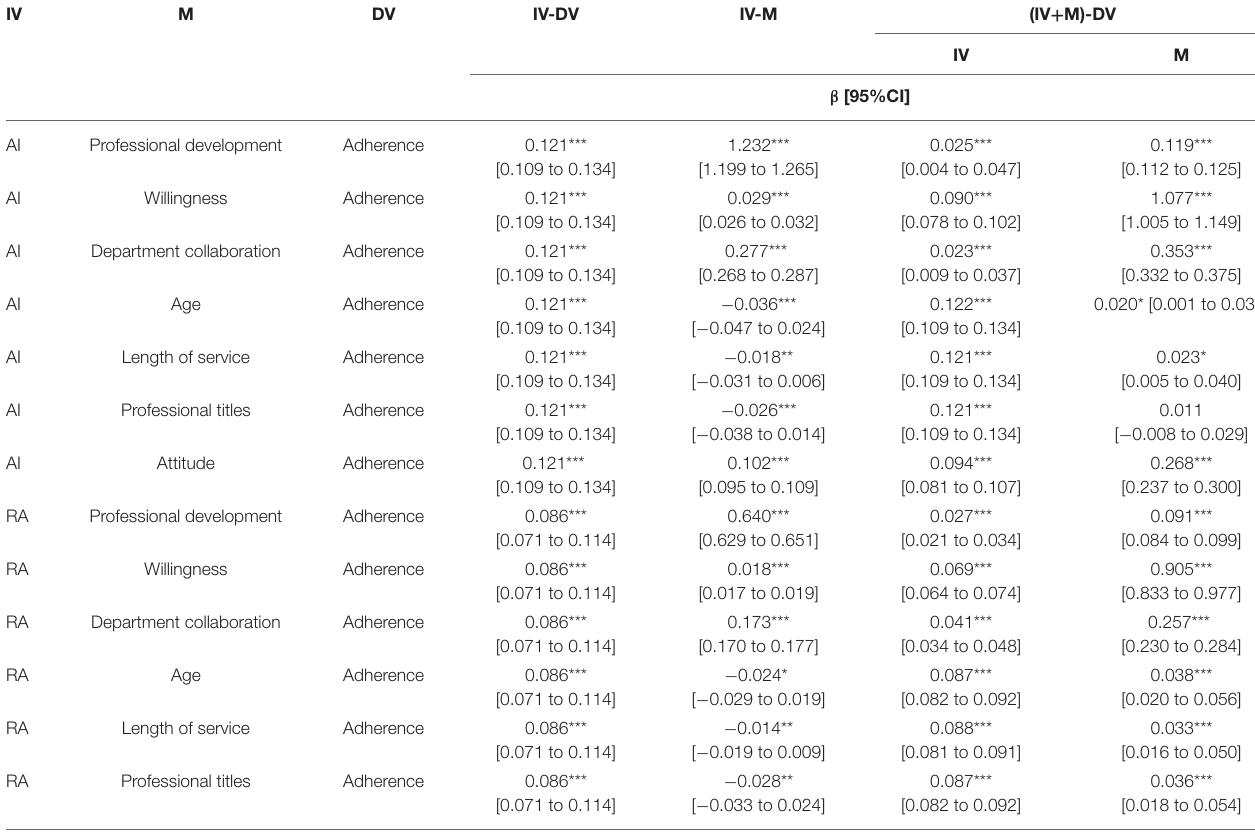
TABLE 5 | Results of mediating effects.